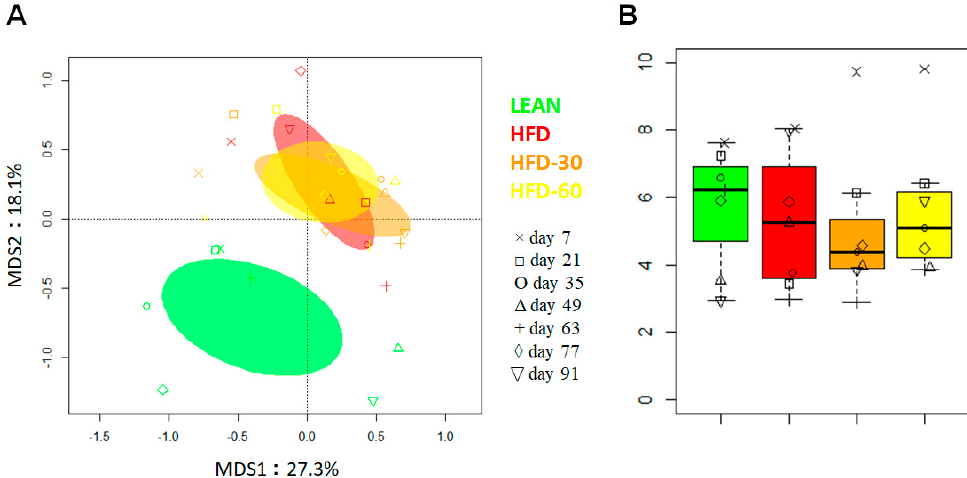
Figure 7. Diversity of the gut microbiota in a mouse model of HFD-induced obesity before and after administration of FLS at different dosages. ( A ) PCoA plot of inter-sample diversity, based on Bray–Curtis distances between the genus-level profiles. Significant separation between the Control group and all other groups was found ( p = 0.001, permutation test with pseudo-F ratio). Samples are identified with different colors and symbols according to group and time point. Ellipses include 95% confidence area based on the standard error of the weighted average of sample coordinates. ( B ), Boxplots showing the distribution of alpha diversity, according to the inverse Simpson index, in the Control vs. HFD vs . HFD + FLS 30 vs. HFD + FLS 60 groups. Symbols indicate the different time points as in (A).